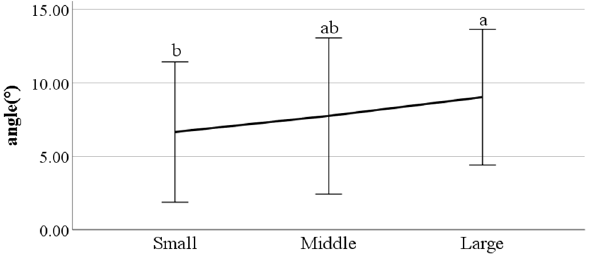
Figure 27. Foot angle at heel-strike (F value: 4.19, DF: 2, p -value: 0.02).